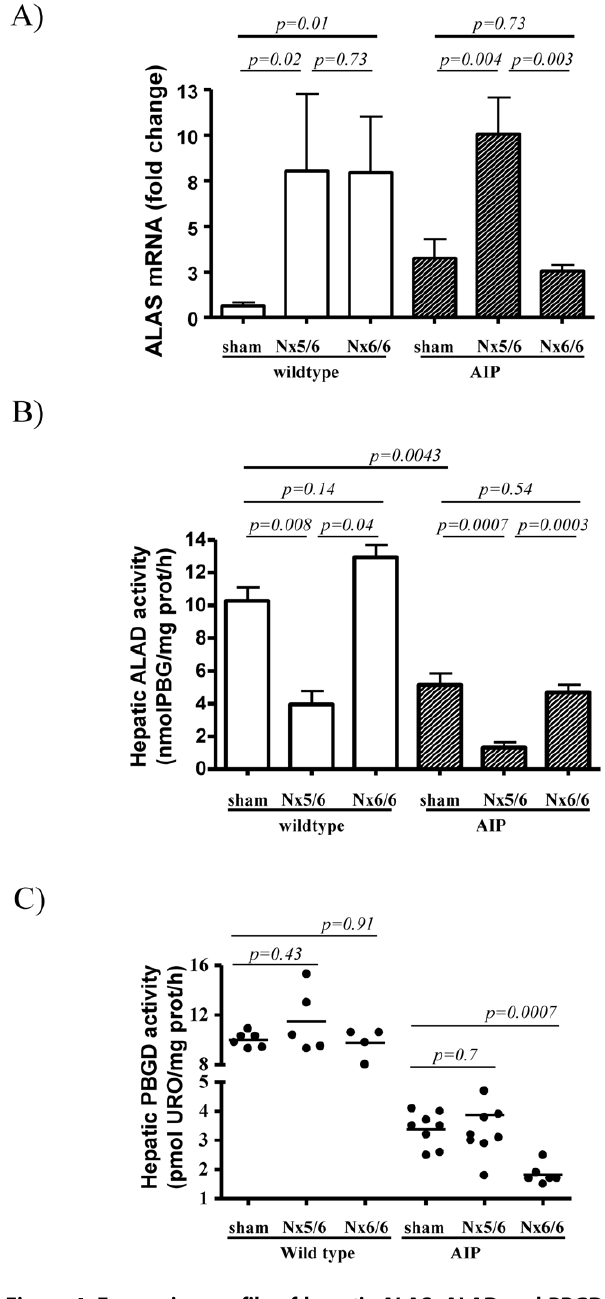
Figure 3. Expression profile of hepatic ALAS, ALAD and PBGD in female wild type and AIP mice suffering from different degrees of renal insufficiency. A group of 4 wild type and 9 AIP female mice were subjected to 5/6 nephrectomy (5/6 Nx) while complete bilateral nephrectomy was performed in 6 wild type and 7 AIP mice. A group of 5 wild type and 6 AIP female animals were sham- operated. A) Quantitative real-time PCR analysis of ALAS mRNA from liver samples. The amount of each transcript was expressed according to the formula 2 D Ct(Actin) 2 D Ct(gene) , where D Ct is the point at which the fluorescence rises appreciably above background fluorescence. B) ALAD and C) PBGD activities measured in the liver of mice taken at sacrifice. The non-parametric Mann–Whitney U-test was used for comparison of two groups. Nx5/6, 2/3 nephrectomy of the left kidney and extirpation of the right kidney; Nx 6/6, total nephrectomy. ALAS, hepatic aminolevulinate acid synthase; ALAD, aminolevulinate acid dehydra- tase; AIP, Acute Intermittent Porphyria.